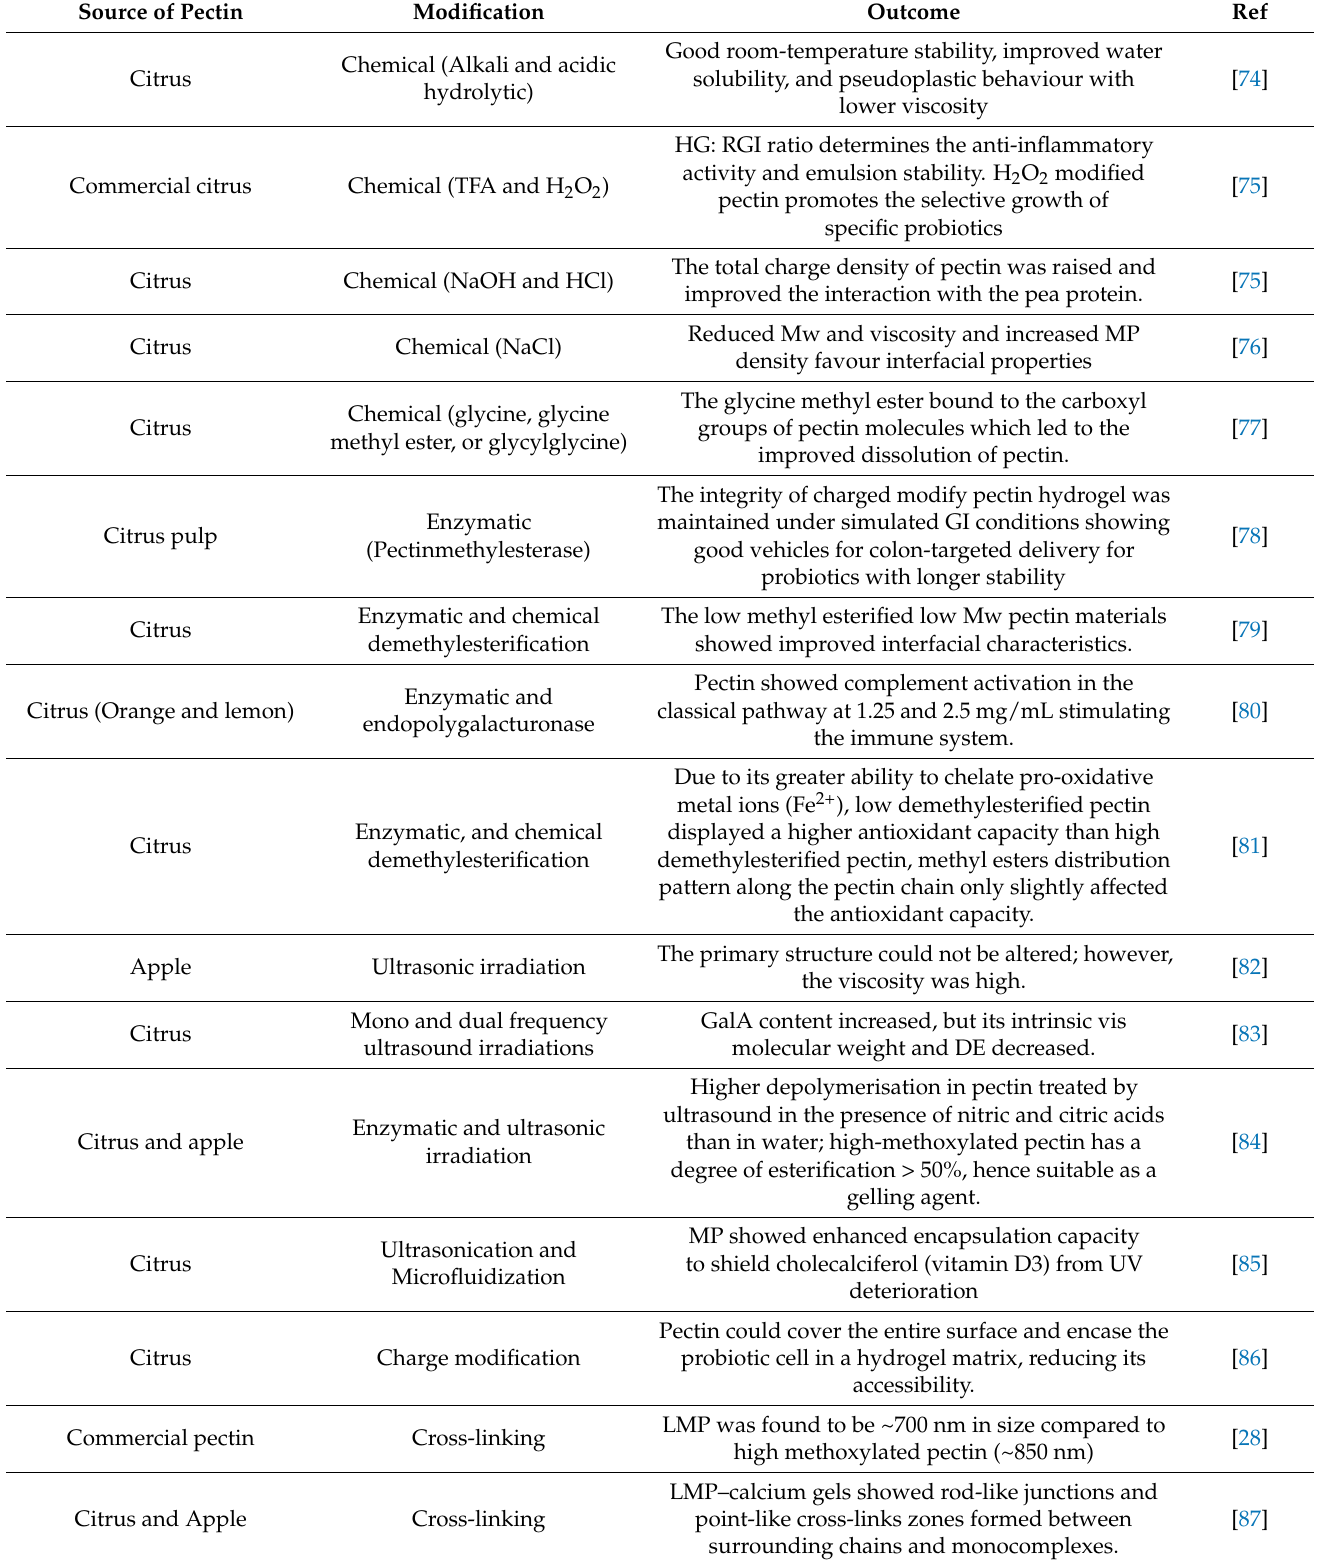
Table 2. Mode of operation in pectin